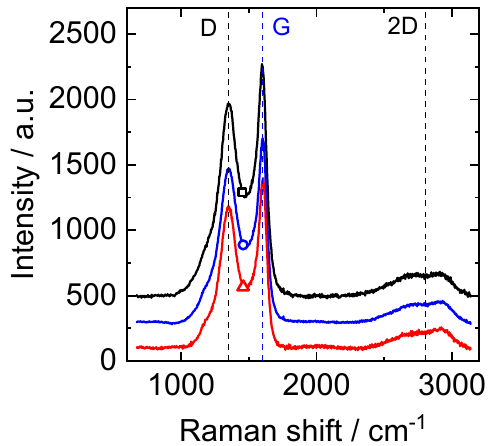
Figure 6. Raman spectra of the samples SucNaCl0.80 ( □ ), SucNaCl1.00 ( ○ ) and SucNaCl1.25 ( △ ).